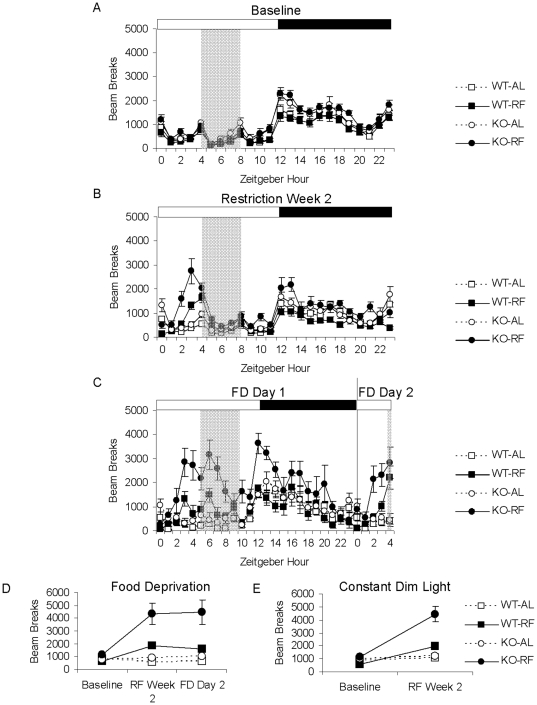
Enhanced FAA in KO mice persists after two days of food deprivation and in the absence of light cues.24-hour activity profiles of WT (squares) or KO (circles) assigned to ad libitum (white symbols) or restricted feeding (black) groups, averaged over A. baseline B. second week of restricted feeding C. first and second day of total food deprivation. D. FAA averaged over the baseline period, second week of restricted feeding, and during the second day of food deprivation. E. FAA averaged over the baseline period and the second week of restricted feeding in constant dim red light. The light/dark cycle is indicated by white/black bars above, the restricted feeding schedule and corresponding time windows for ad libitum control groups and during the food deprivation period are indicated by gray shading. Values represent means ±S.E.M.